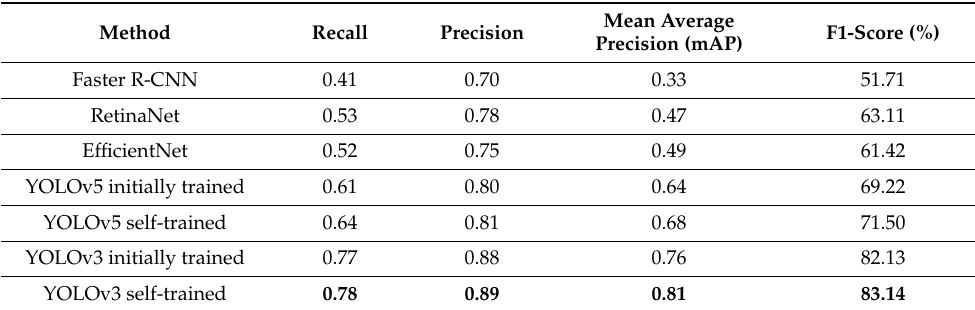
Table 3. Overall training evaluation metrics (best result in bold) for an orthophoto product for 30% of the input data (1900 test samples out of 6100 images in total).